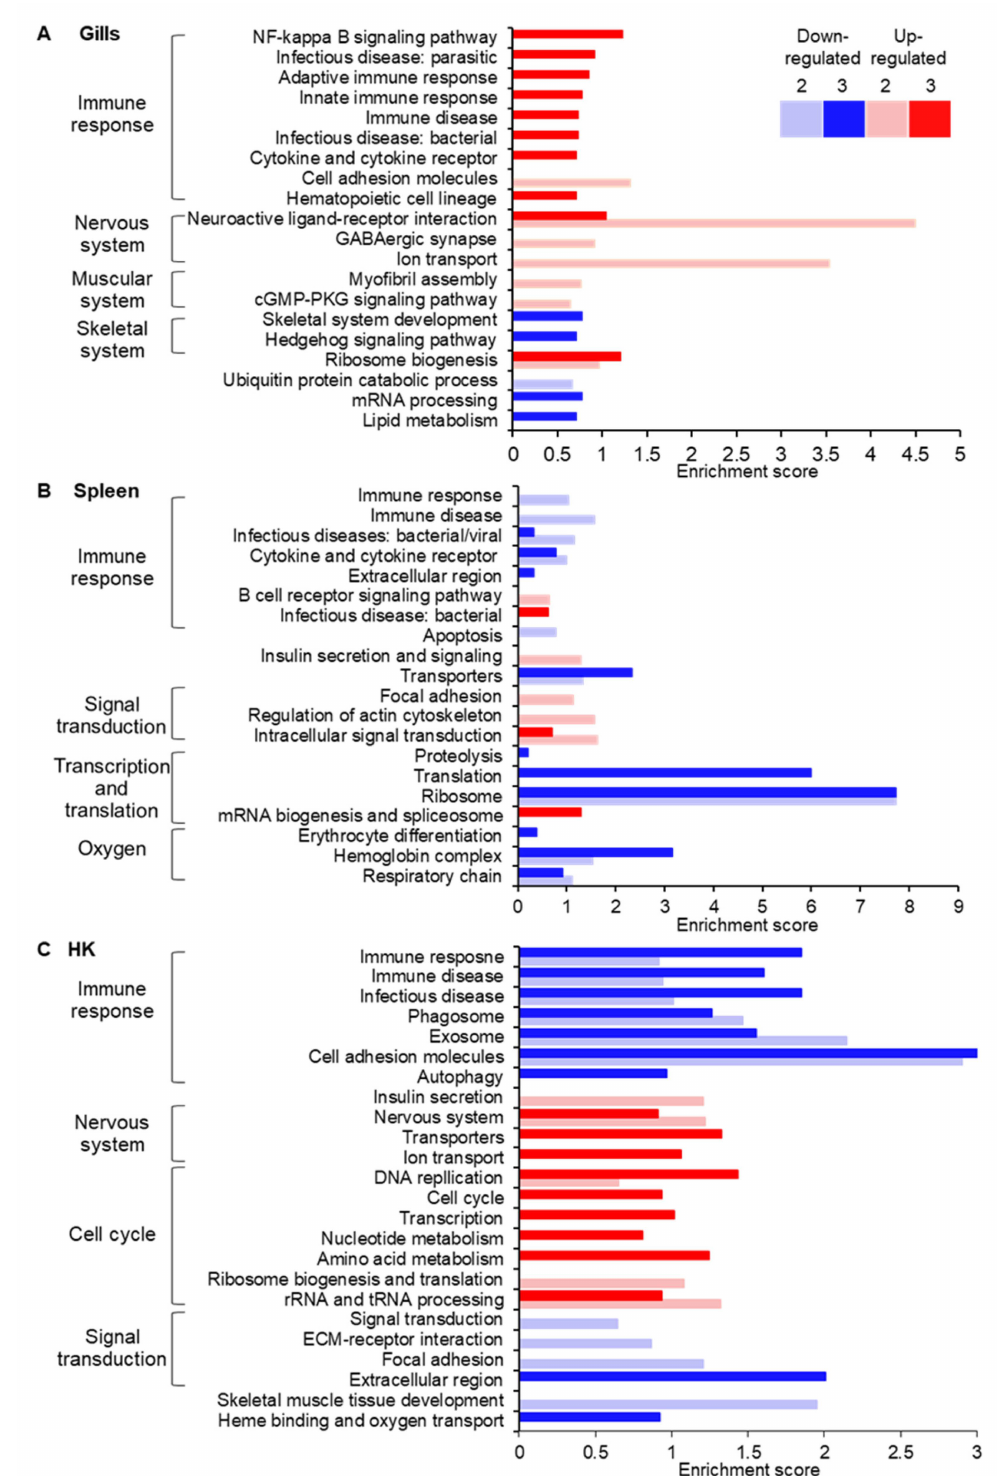
Figure 3. Gene ontology and KEGG pathways enrichment analysis. Enrichment scores, calculated from adjusted p -values, are presented for gills ( A ), spleen ( B ), and HK ( C ) at intermediate (2) (lighter shades) and severe (3) (darker shades) infection stages. Up- and down-regulated processes are indicated by red and blue colors, respectively. Clusters of cellular processes are marked. See Supplementary Table S2 for additional details of GO and KEGG